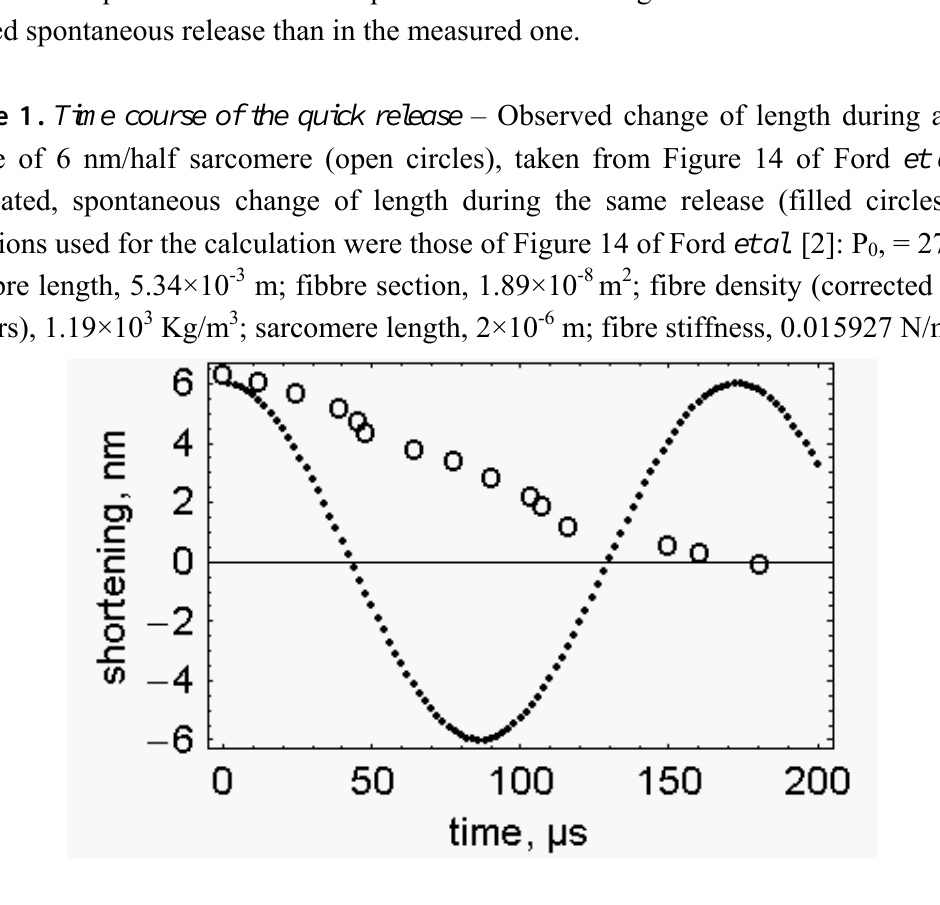
Figure 2. Measured changes of length during the quick release - data are taken from Ford et al . [2]. The releases are given in nm per half sarcomere: 1.5 nm (open circles); 3.0 nm (filled triangles); 4.5 nm (open triangles); 6.0 nm (filled